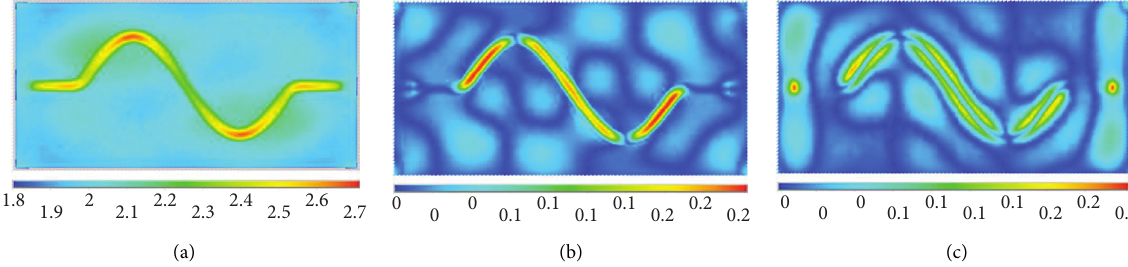
Figure 31: SV wave incident ( H � 100m, f � 1.5Hz, C